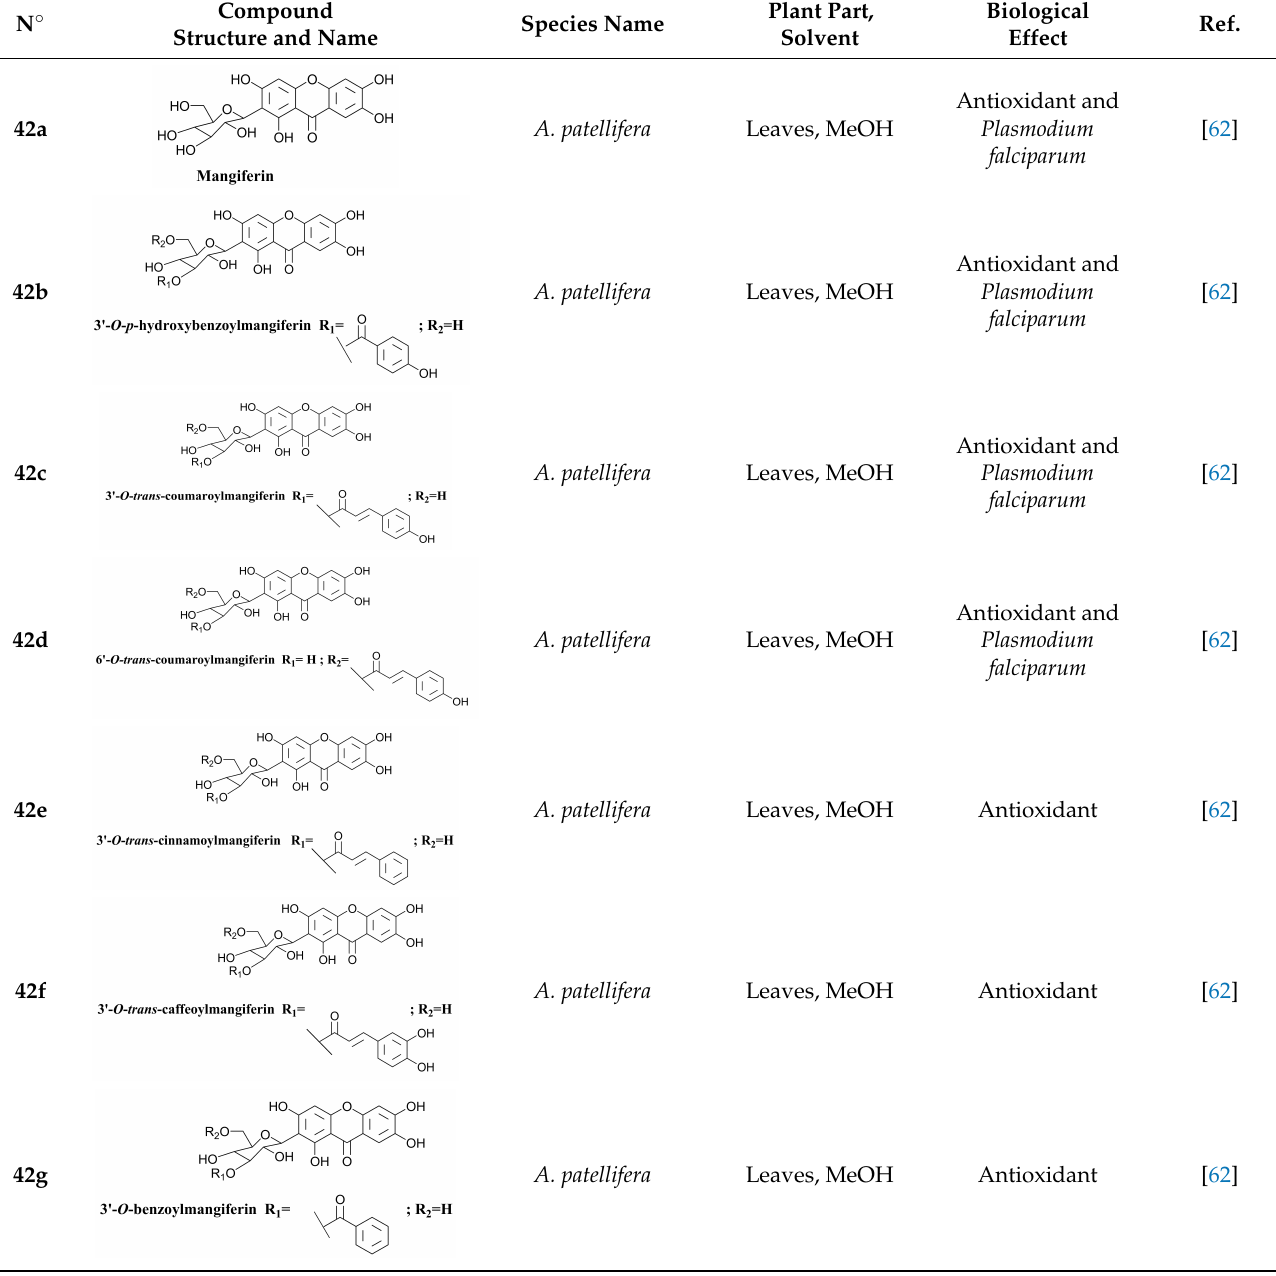
Table 7. Structure and bio-pharmacological properties of isolated compounds from A. patellifera